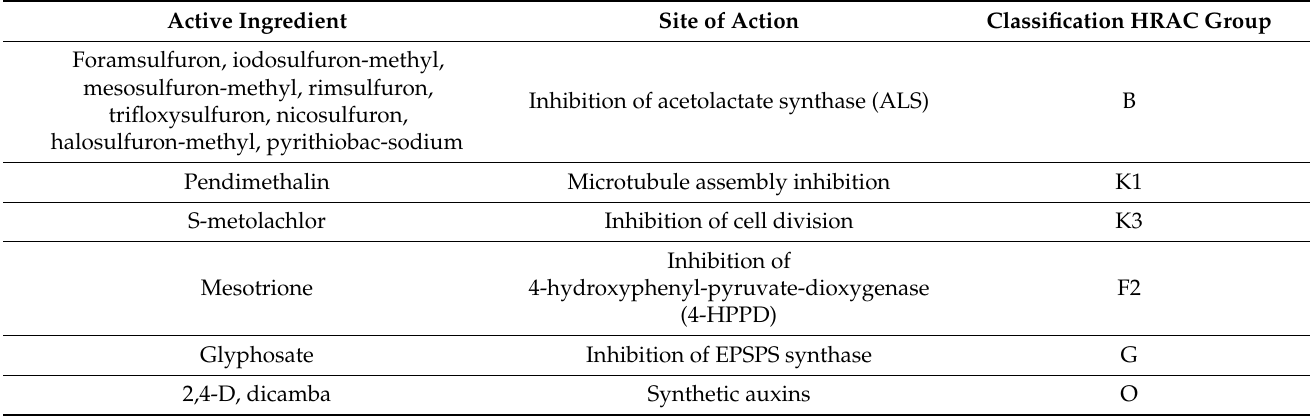
Table 1. Herbicides’ active ingredients to which Palmer amaranth has evolved resistance. Active Ingredient Site of Action Classification HRAC Group Foramsulfuron, iodosulfuron-methyl, mesosulfuron-methyl,